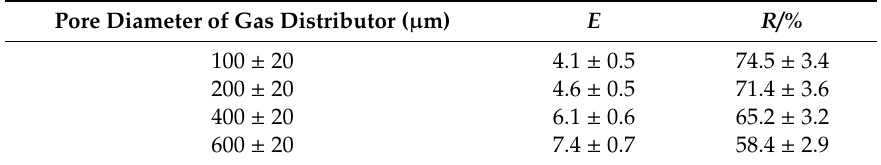
Table 6. E ff ects of pore diameter of gas distributor on enrichment ratio ( E ) and recovery percentage ( R ) of total